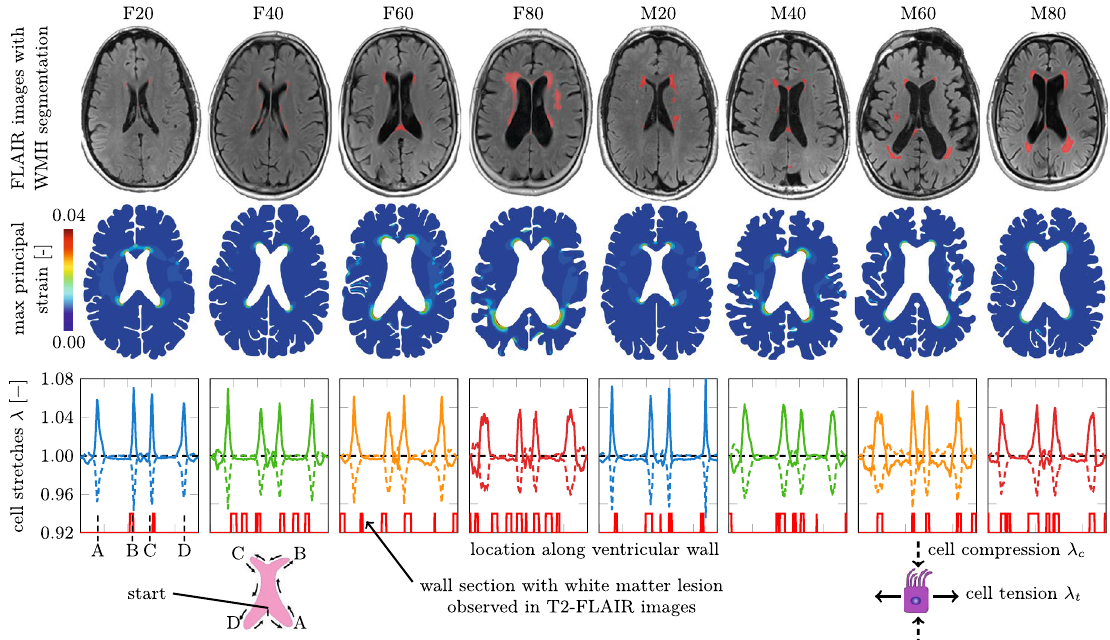
Figure 5. Eight finite element models were created from FLAIR MRI with WMHs shown in red (top row). We simulated quasistatic ventricular expansion during peak loading to determine ventricular wall strain and ependymal cell stretch. The distribution of maximum principal strain (middle row) is consistent across all individuals, with peak strain localizing around the anterior and posterior horns of the lateral ventricles. Based on the deformation fields, we determine ependymal cell stretch along the ventricular wall. We calculate ependymal cell tension, which is tangential to the ependymal wall, and ependymal cell compression, which is perpendicular to the ependymal wall. We observe four distinct locations with maximum stretches along the wall. These coincide with the horns, as indicated by points A, B, C, and D. We report both stretch components for every point along the ependymal wall as shown in the ventricular representation in the legend.